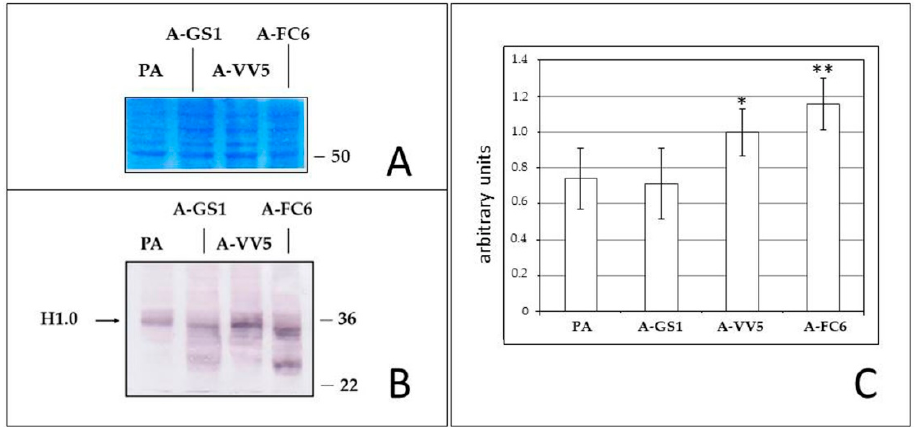
Figure 7. Western blot analysis of total lysates from primary astrocytes (PA), and from the three clones derived from them. (A) Coomassie blue staining of a piece of the same membrane used for the western blot analysis shown in (B); ( B ) representative blot showing distribution of the bands recognized by the anti-H1.0 antibody; position of the main expected H1.0 band is indicated, together with the positions of two reference markers; ( C ) graphical representation of the statistical analysis. Only the main upper band was considered. * p < 0.01 (vs. PA); ** p < 0.001 (vs. PA).